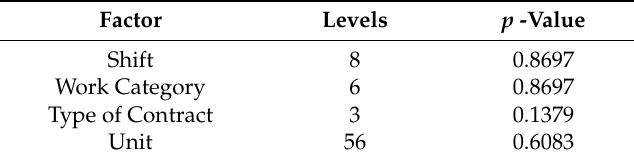
Table 5. Kruskal–Wallis analysis of Staff organizational factors.